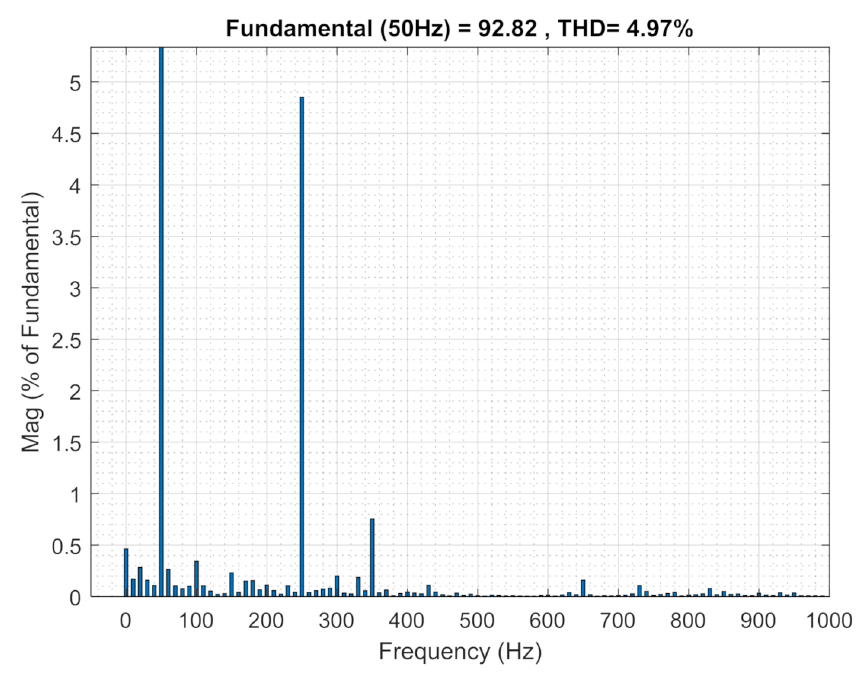
Figure 20. Experimental THD of line